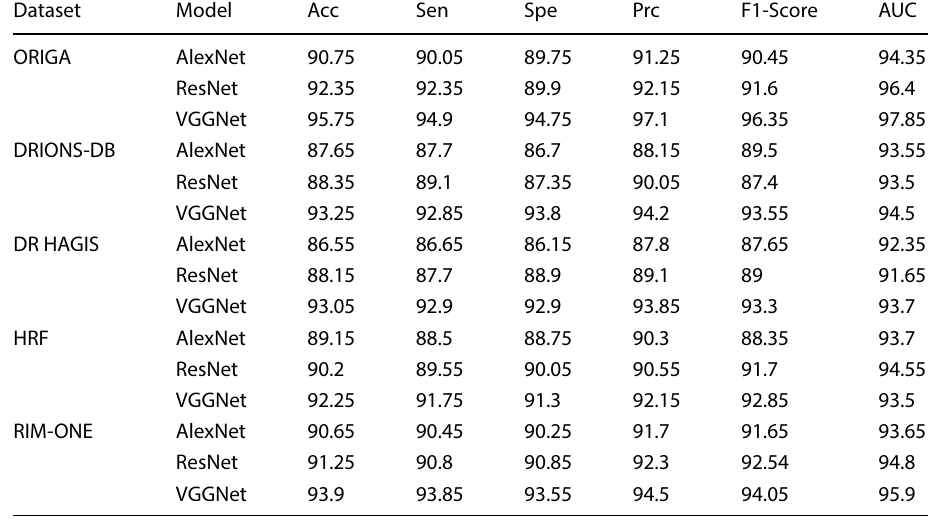
Fig. 5 The effectiveness of the proposed glaucoma diagnosis system for ORIGA, DRIONS-DB, DR-HAGIS, HRF, and